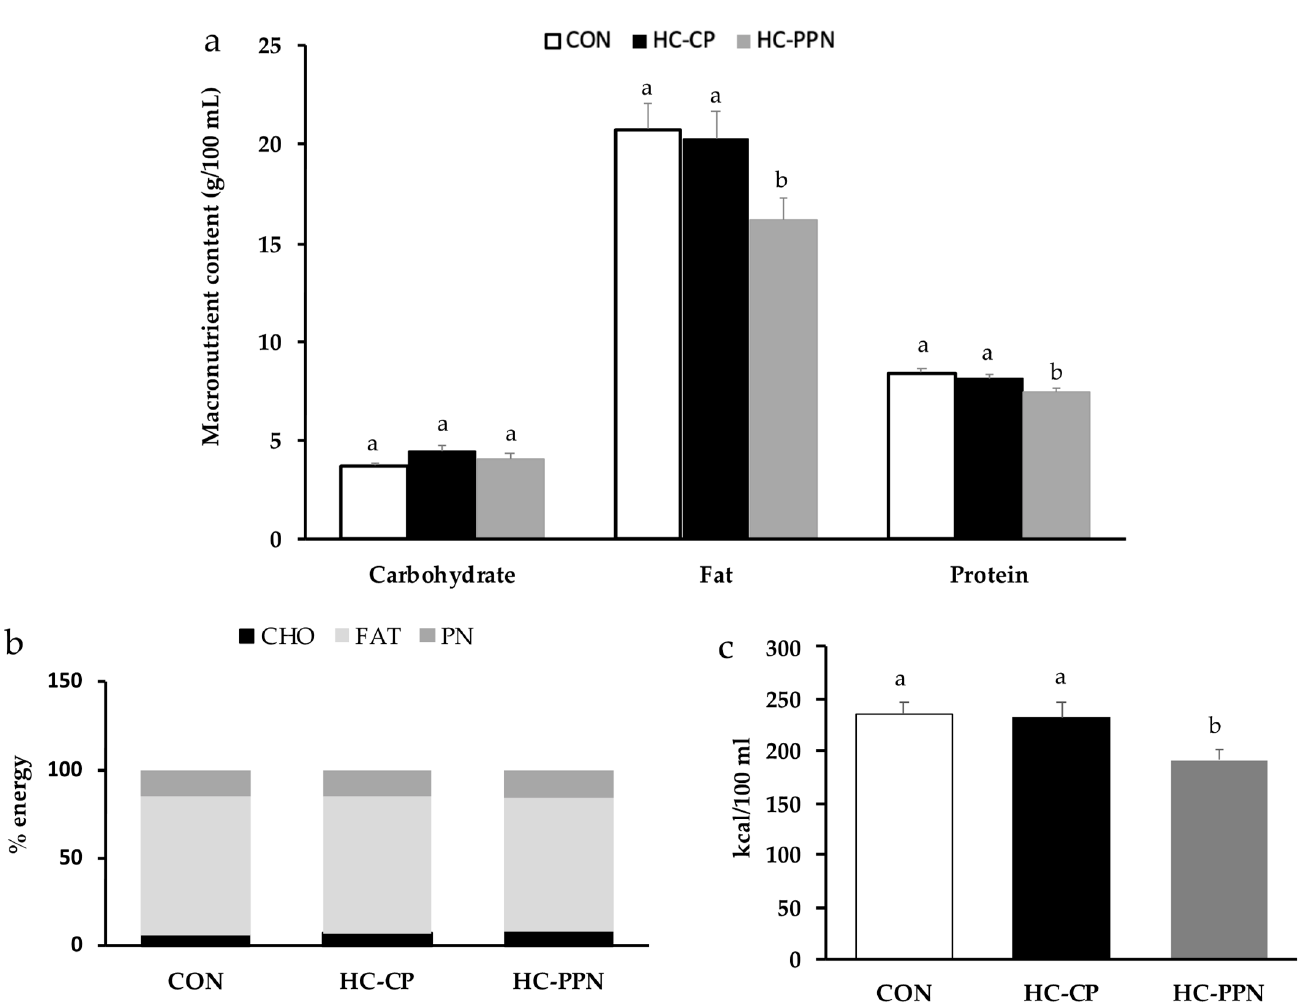
Figure 2. Nutrient content of maternal milk on lactation day 15. ( a ) Macronutrient content presented as g/100 mL; ( b ) macronutrient content presented as % energy; and ( c ) total energy content. CON, low-calorie control diet; HC-CP, high-calorie obese-inducing diet with casein protein; and HC-PPN, HC high-calorie diet with supplemental yellow pea protein (25%). ab Treatment groups within sex that do not share a superscript are significantly different ( p < 0.05). Data are means ± SE, and n = 7–9 mothers per group.